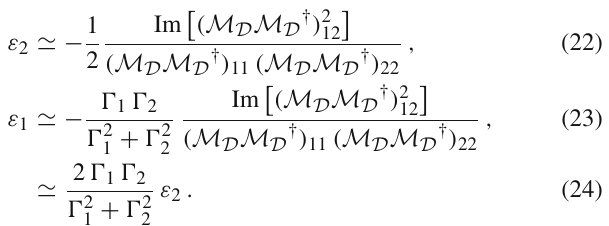
Fig. 3 Left panel: Variation of the CP asymmetry parameter ε 1 with the mass of N 1 . Right panel: Variation of total decay width of N 1 with M N . A black solid line represents the upper bound of (cid:13) 1 coming from 1